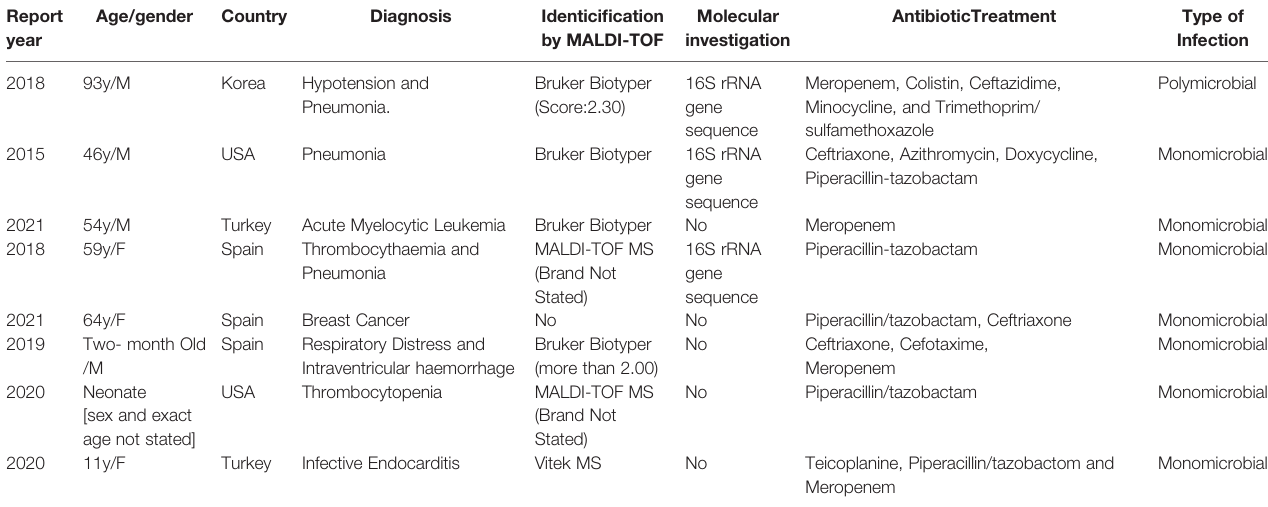
TABLE 3 | Cases of H. huttiense infections in humans reported in the